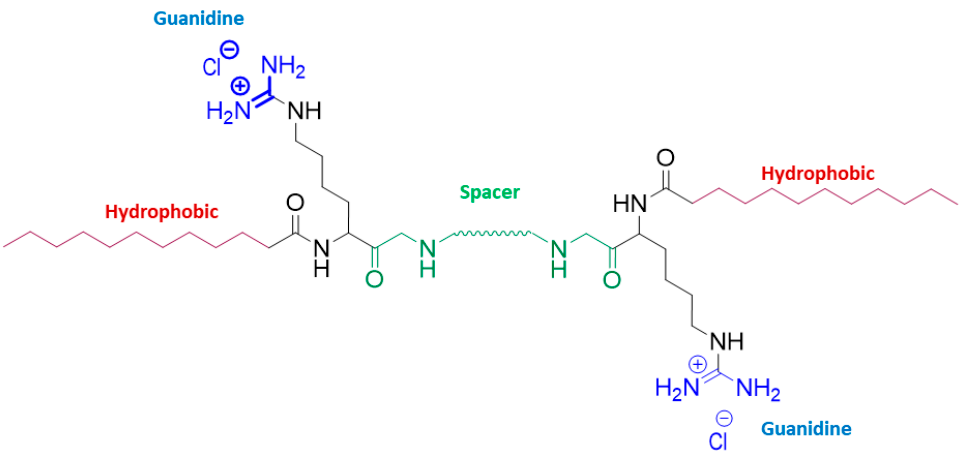
Figure 11. Different parts of the molecular structure of surfactants that interact with zein structures